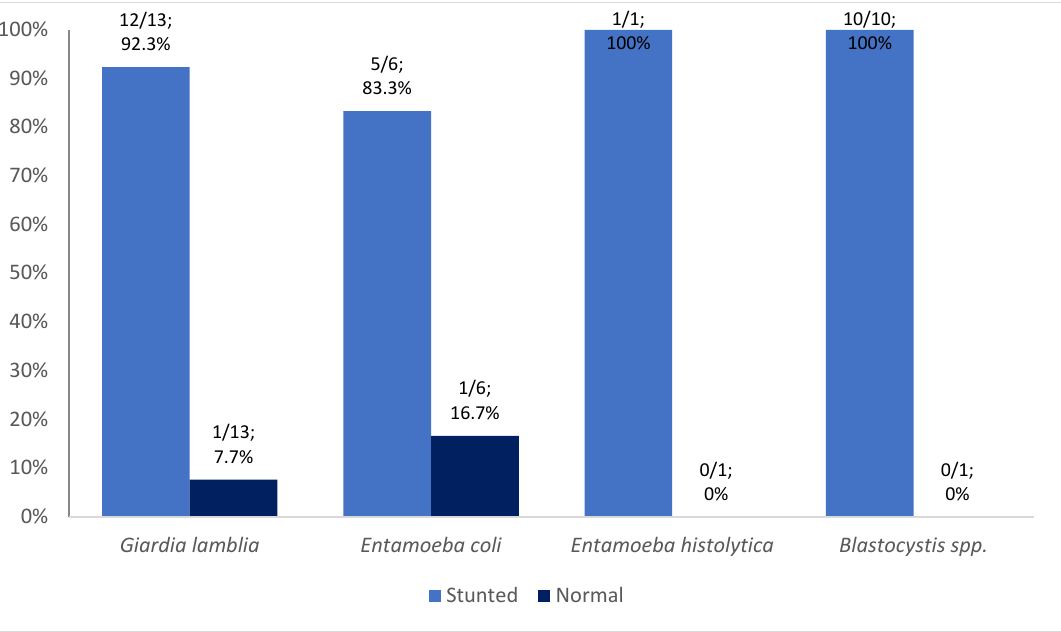
Figure 4. Intestinal protozoan distribution in stunted and normal children in East Nusa Tenggara; n = 30 children. Giardia lamblia was detected in a total of 13 children; Entamoeba coli was detected in a total of 6 children; Entamoeba histolytica was detected in a total of 1 child; Blastocystis spp. was detected in a total of 10 children (one child had ≥ 1 protozoan parasites).